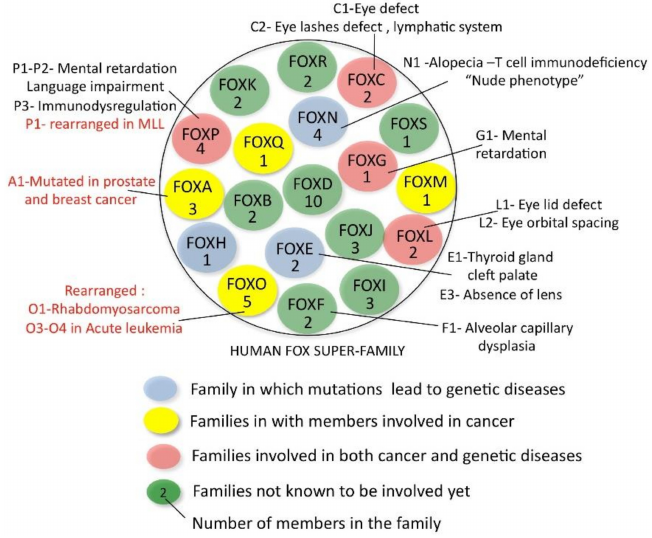
Figure 1. A schematic representation of the human FOX family of transcription factors. The members involved in genetic diseases and cancer are indicated. The arrangement of the families is independent from functional or evolution